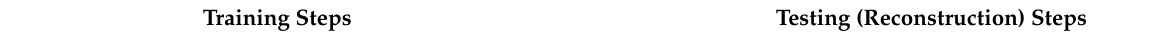
Table 1. A summary of the training and testing (reconstruction) process of